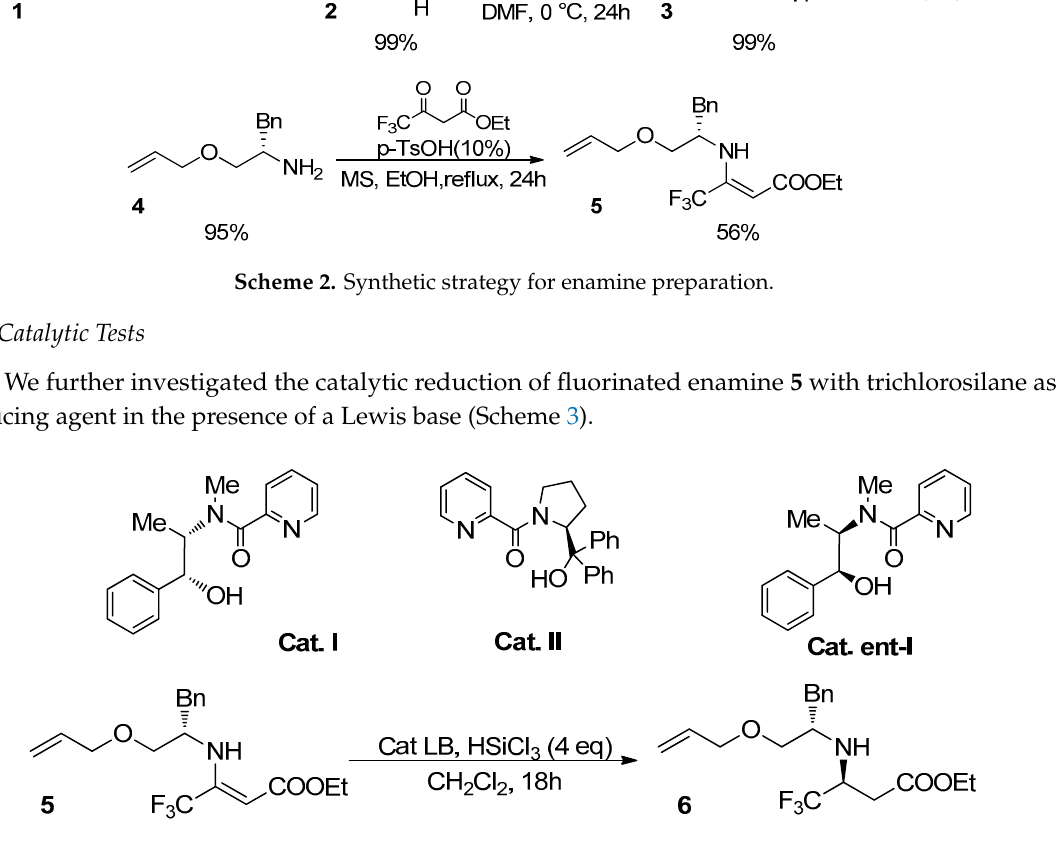
Table 1. Diastereoselective catalytic